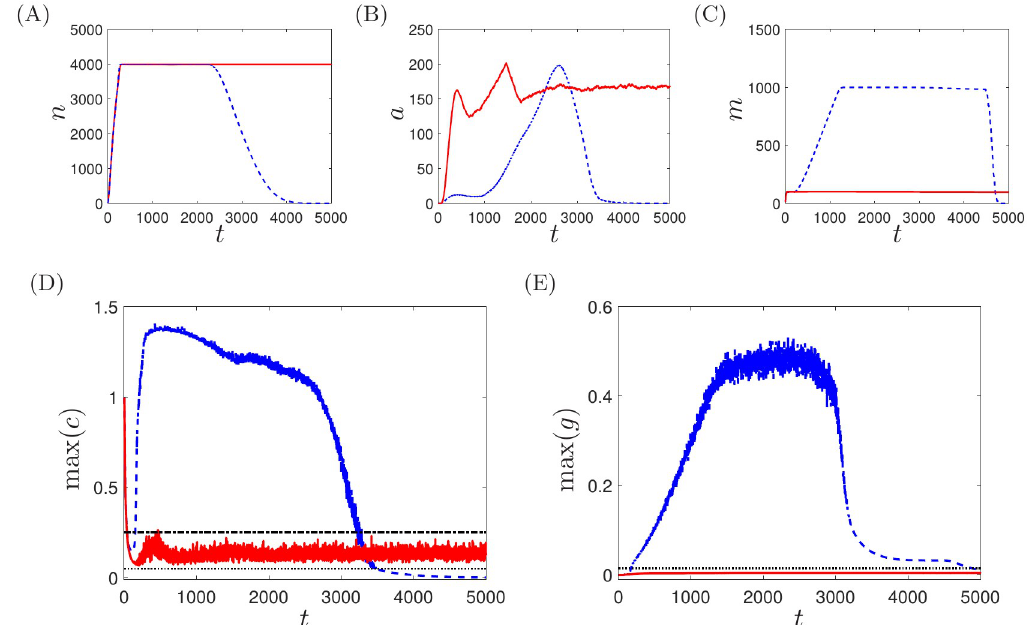
Fig 11. Simulations for α = 0.25 and all other parameters as given in Table 1, with healthy neutrophil chemotaxis ( k mr 80, σ = 1, shown as dashed blue lines) and impaired neutrophil chemotaxis ( k mem lines). (A–C) Global cell counts for active neutrophils, apoptotic neutrophils and macrophages respectively. (D,E) Maximal concentrations of mediators c and g across the domain. Dotted lines demark the thresholds for neutrophil recruitment ( c = α g = α ngr ); the dash-dotted line demarks the threshold for macrophage recruitment ( c = α mr ). Impaired neutrophil chemotaxis causes a previously healthy outcome to become chronic.